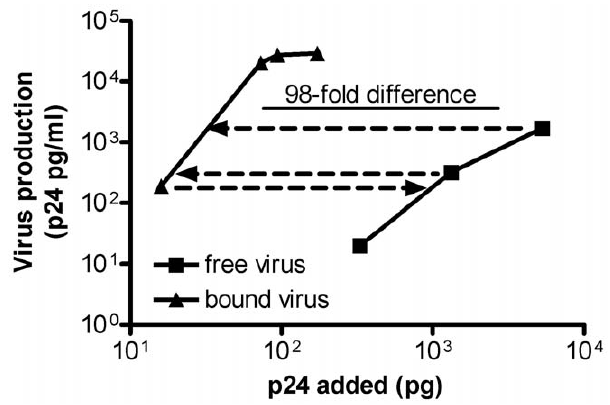
Figure 6. Erythrocyte-adsorbed virus is more infectious, based on p24, than free virus. To compare the infectivity of cell-bound virus with free virus-1, HIV isolate 90US_873 was bound to erythrocytes (sample no. Q6). Increasing numbers of erythrocytes containing bound virus were then added to a PBMC culture, and virus production was determined on day 4 post-infection. The amount of virus production was then compared with that obtained by incubating the original free virus with PBMC. A similar result was obtained in a second experiment with a different donor (no. T1) and HIV-1 isolate 89BZ_167.